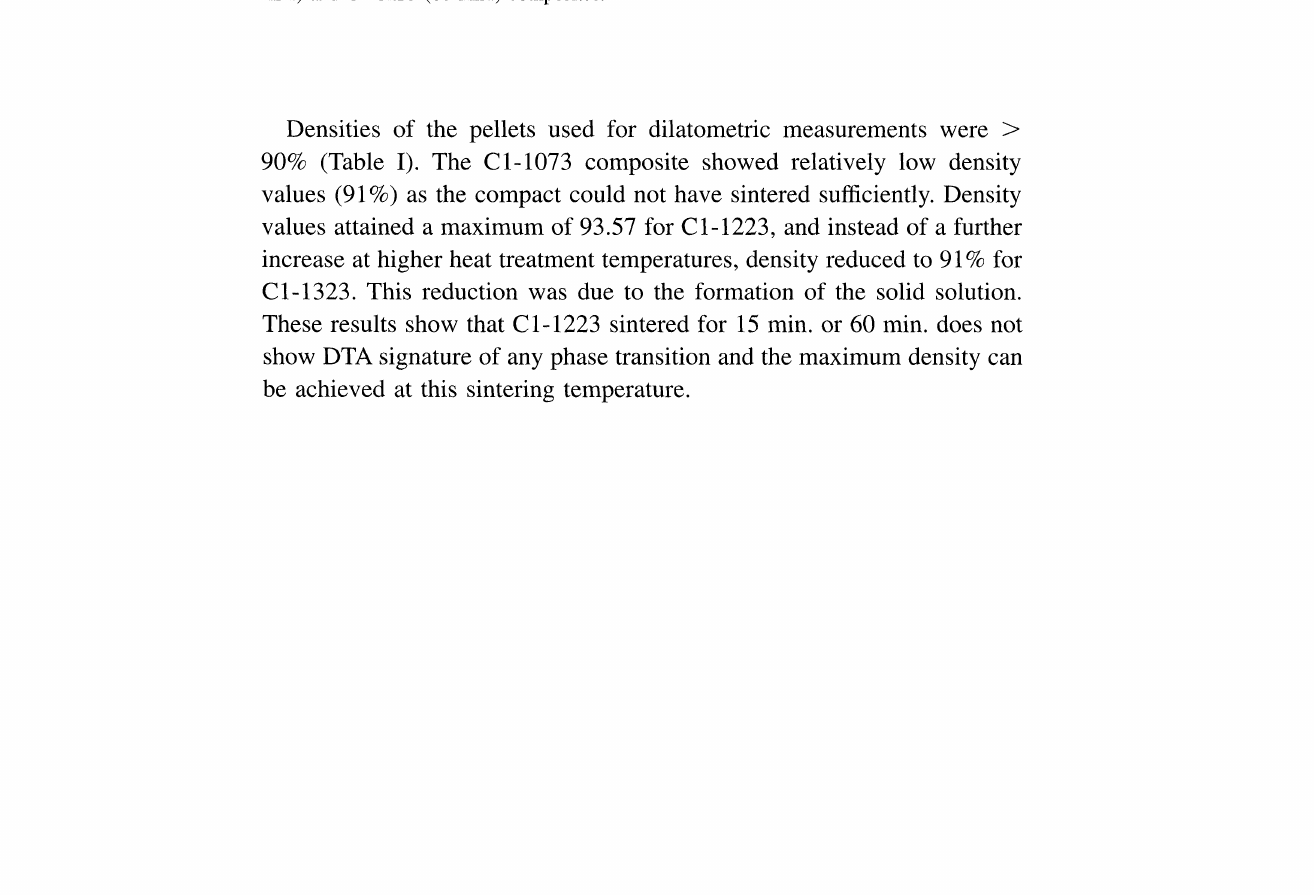
FIGURE 3 The heating and cooling DTA curves for the C1-1073 (15 rain.), C1-1173 (15 rain.) and C1-1223 (60 rain.) composites.